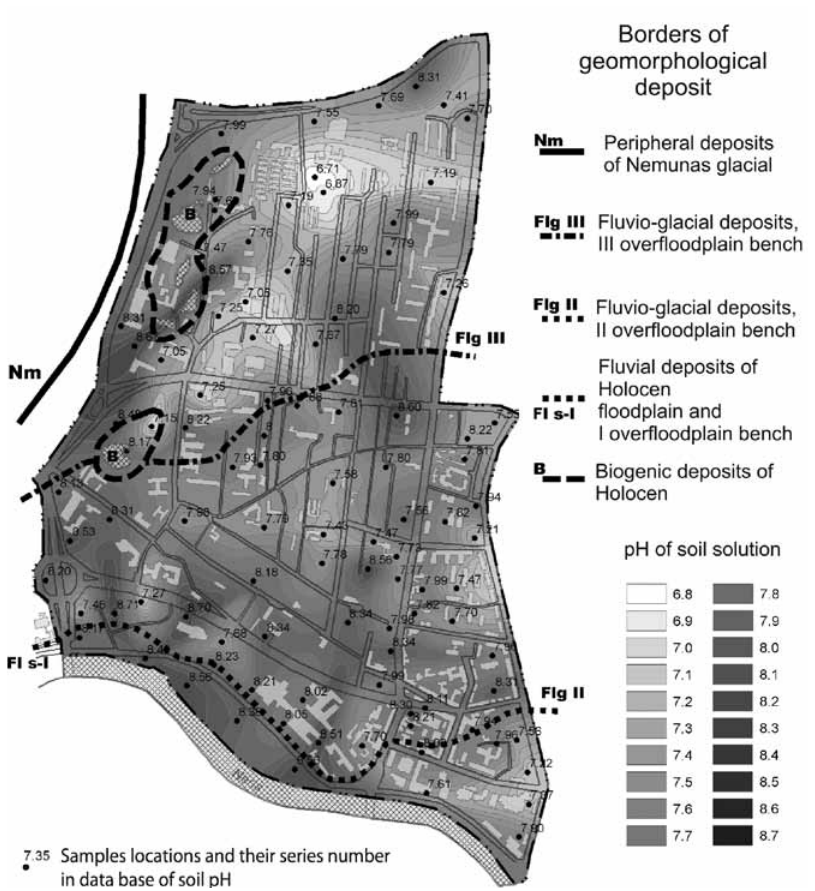
Fig. 2. Specific soil samples locations and soil pH values in eldership of Šnipiškės of the city